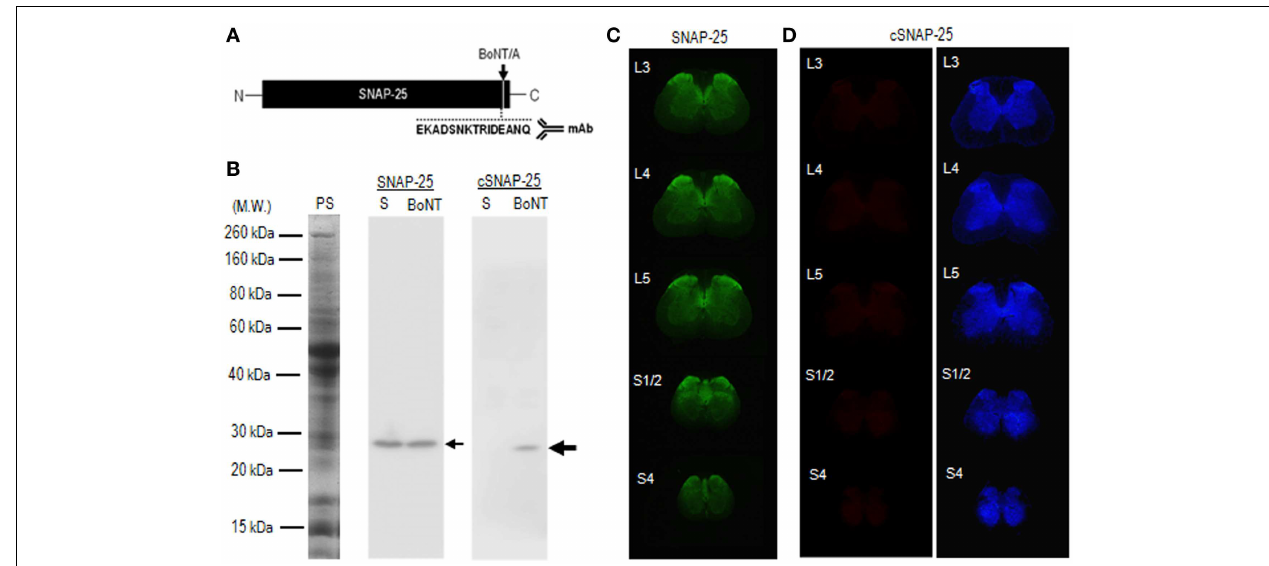
Twenty micrograms of protein were loaded on each lane. Protein staining (PS) and immunostaining for SNAP-25 and cSNAP-25 are shown. Small arrow indicates SNAP-25 protein with an apparent molecular weight of 25kDa. Large arrow indicates cSNAP-25 protein with an apparent molecular weight of 24kDa. Note that mAb against cSNAP-25 reacts with the cleaved, but not non-cleaved, form of SNAP-25 protein. (C) Multiple transverse spinal sections stained for SNAP-25 from saline-treated rats. (D) Multiple transverse spinal cord sections stained for cSNAP-25 from saline-treated rats (left panel), and their graded color-converted images (right